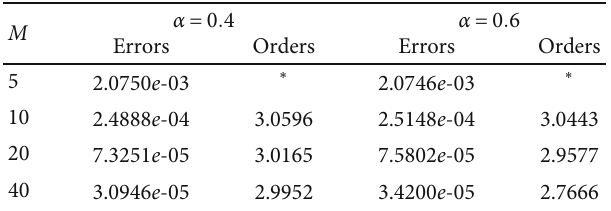
Table 5: The errors and orders in temporal direction and spatial direction by using